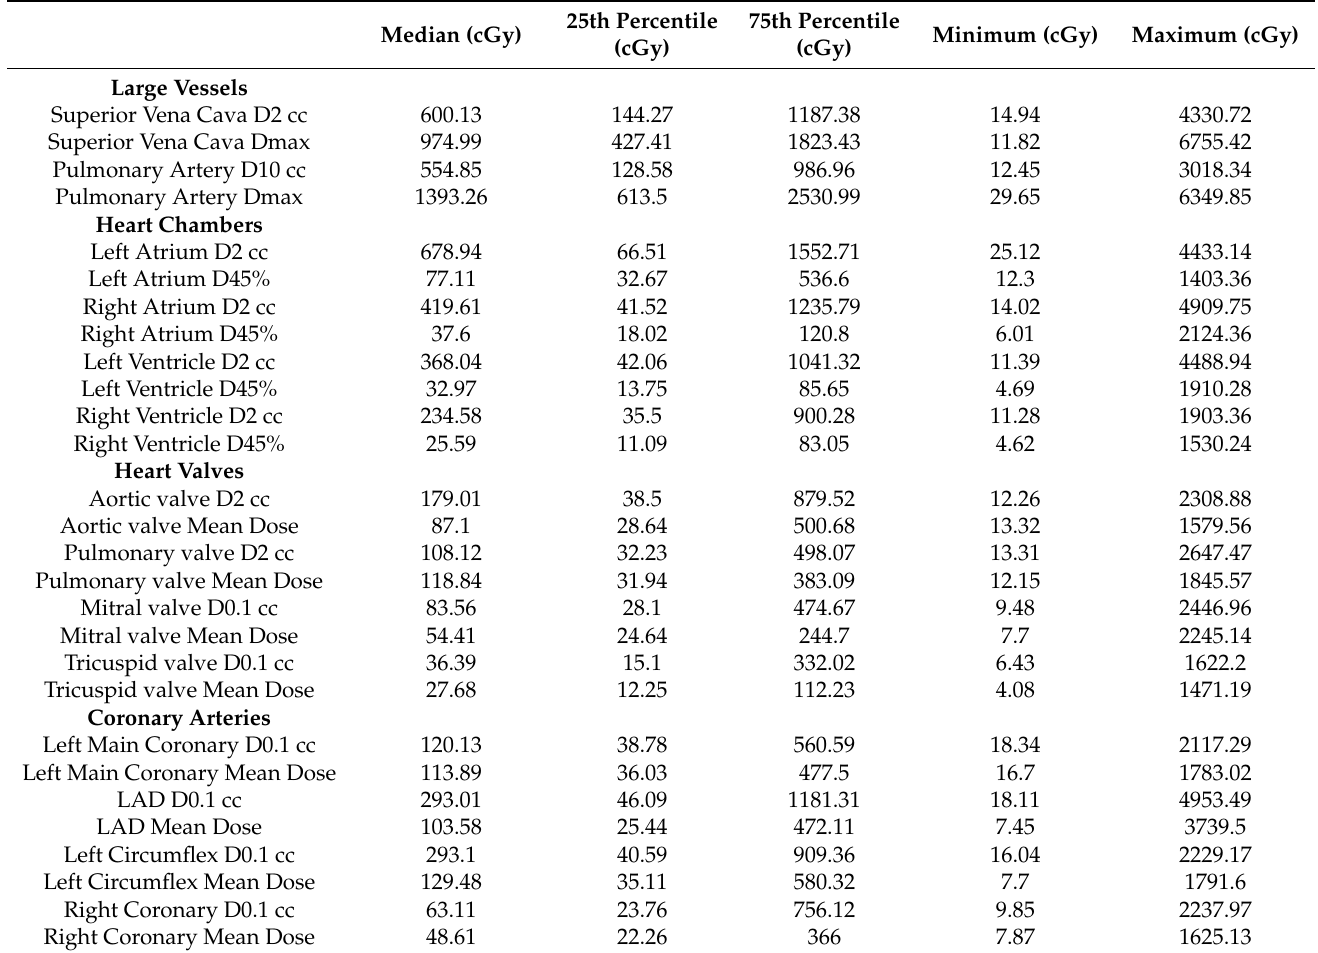
Table 2. Radiation dose to cardiac